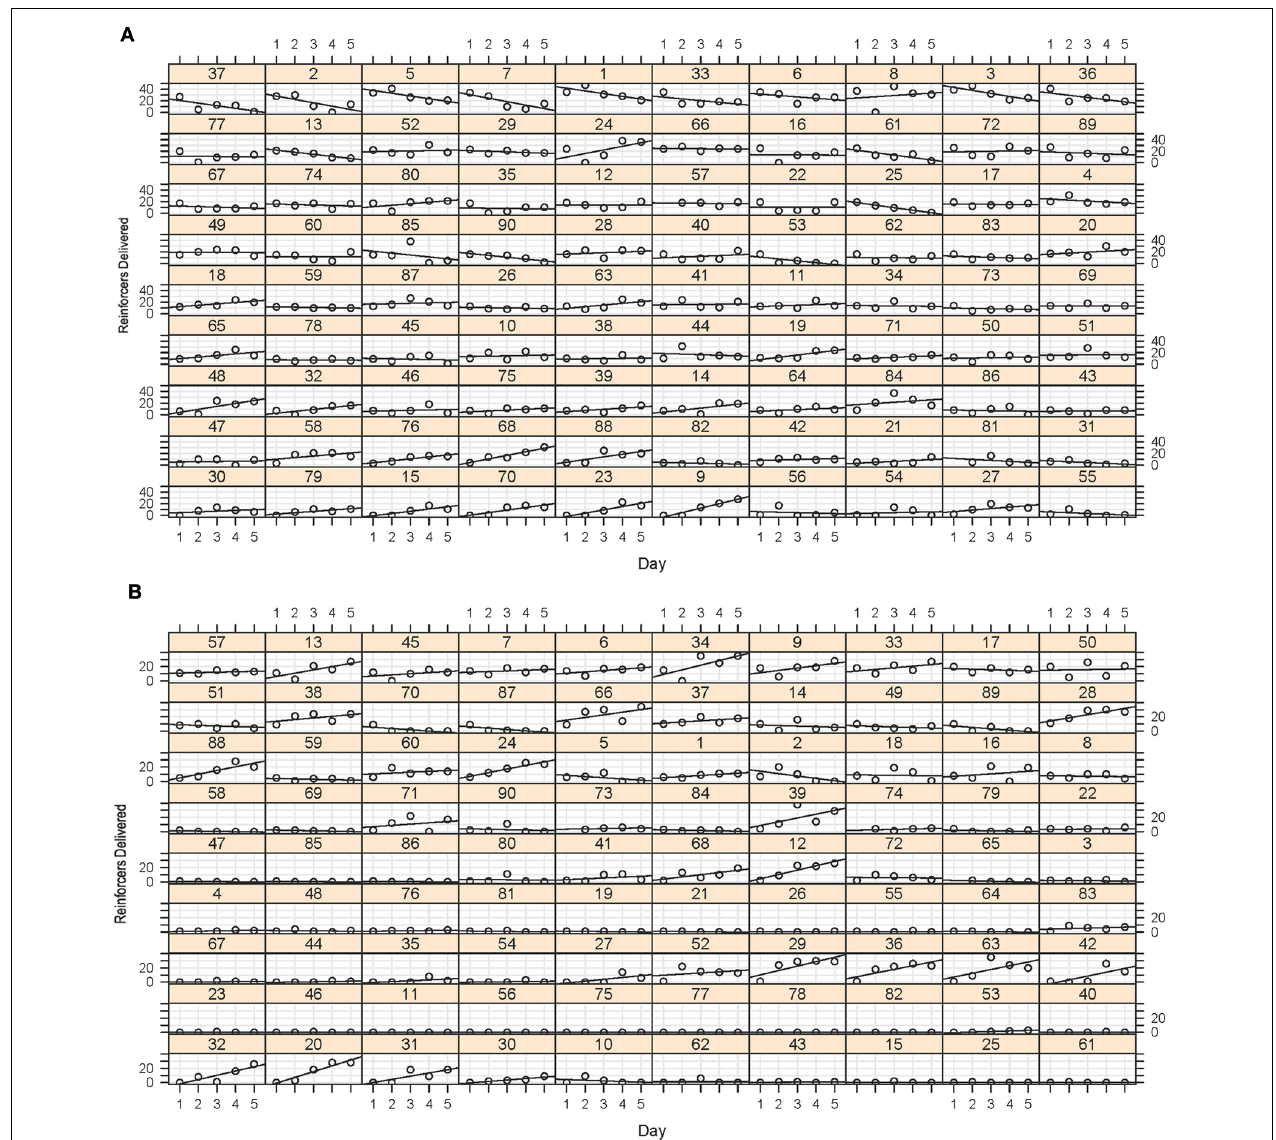
FIGURE 5 | (A) Magazine training data. This array displays the number of entries to the food magazine during the magazine light illumination during the five sessions for each of the 90 fish. Although some of the fish showed some evidence of a positive least-squares (LS) regression slope of entries during the sessions, this was certainly not the case for all fish, with many showing a